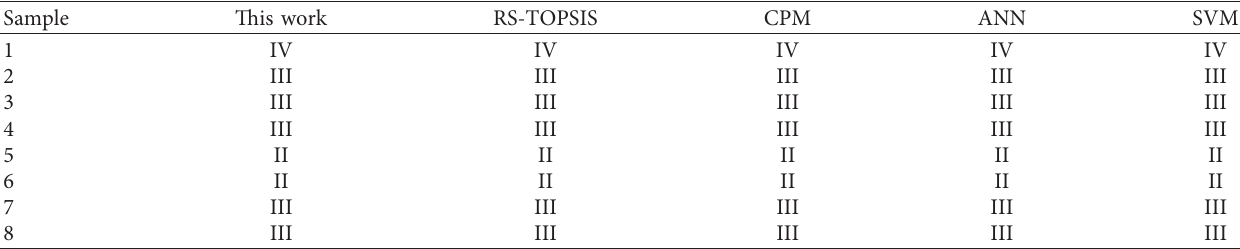
Table 5: Comparison of results of rock mass quality